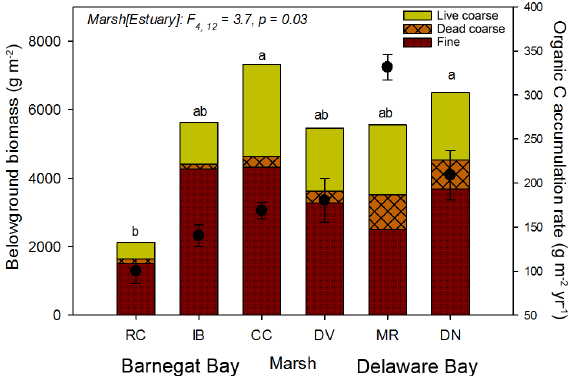
Figure 6. Belowground biomass (scaled on left axis) and organic C accumulation rate (scaled on right axis; previously reported in Unger et al., 2016) in marshes of two mid-Atlantic estuaries. Be- lowground biomass and C accumulation are relative to the 137 Cs peak depth. Statistics for total belowground are shown and letters represent differences ( p <0.05). Standard errors are shown in Ta- ble